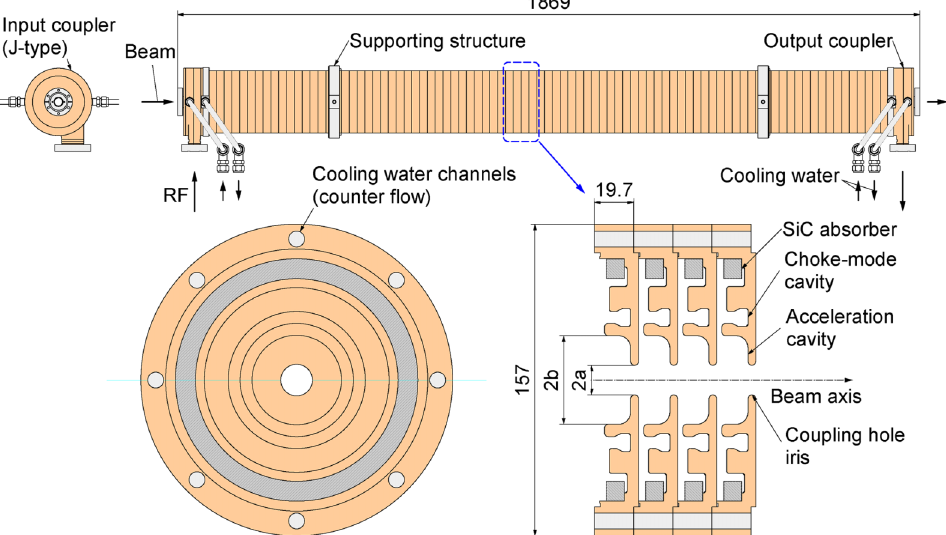
FIG. 4. Top view (top) and the cross sectional view (bottom) of the C -band choke-mode accelerator structure.